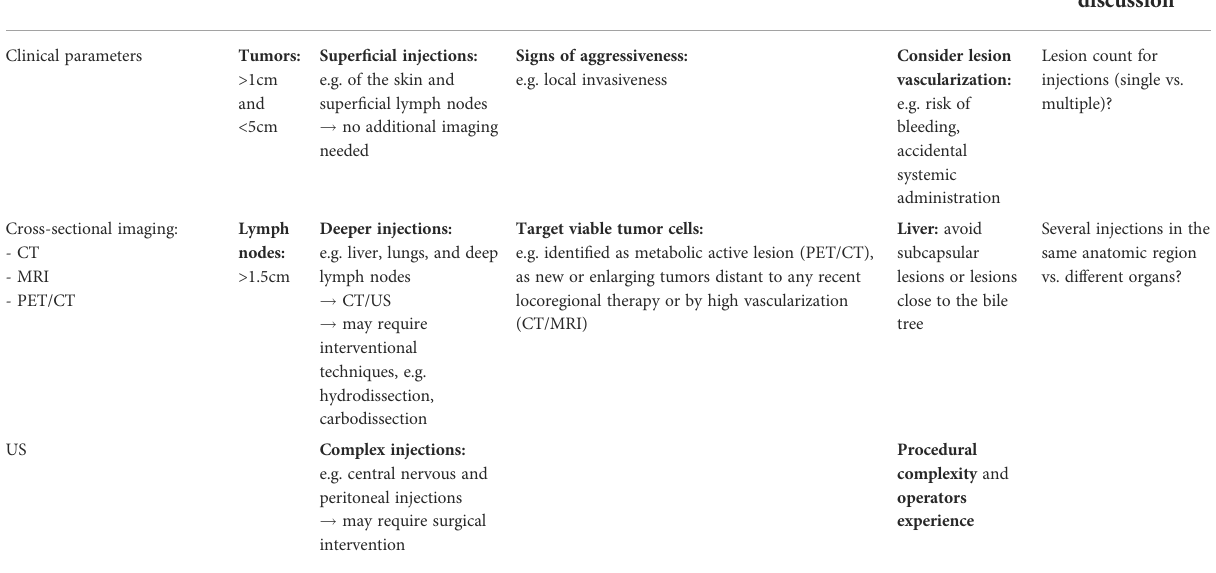
TABLE 4 Summary of factors for prioritizing lesions for injection. Tumorcharacterization Tumor